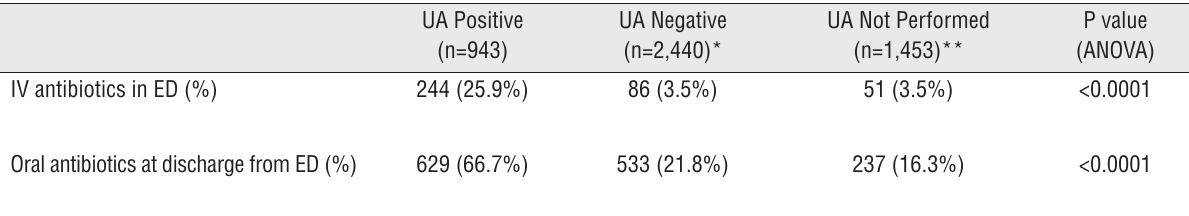
Table 2 - Utilization of antibiotics based on UA